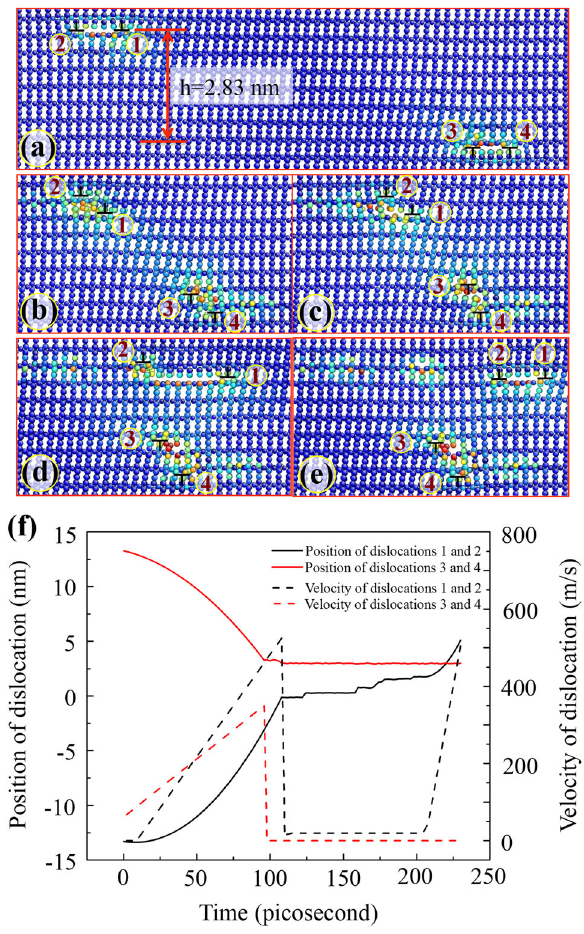
Fig. 2 Interaction of a pair of dislocation dipole with the separation of h = 2.83 nm. At temperature of 300 K, atomic structures asso- ciated with a the glide of four partials, b the climb of partials 1 and 3 for four atomic planes, c the climb of partial 3 for seven atomic planes, d the stacking fault is created associated with the glide of partial 1 and the pinning of partial 2, and the climb of partial 3 for eight atomic planes, and e the climb of partial 2 on the same plane as partial 1, and then they glide together. Dislocations annihilation does not happen. The symbol “ ⊥ ” indicates the position of